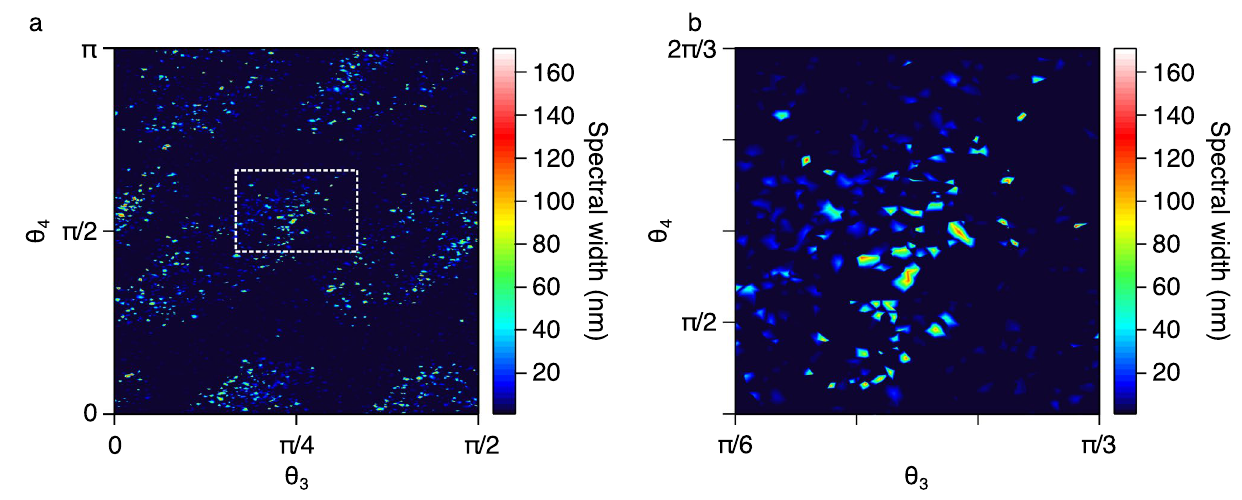
Figure 2. ( a ) False-color plot mapping how the − 20 dB spectral bandwidth of the laser output varies as a function of waveplate angles θ 3 and θ 4 with pump power at 195 mW. ( b ) An expanded view over the region indicated by the white square in ( a ) to illustrate the rarity of operating states of bandwidths exceeding ∼ 100 nm (corresponding to red regions in the